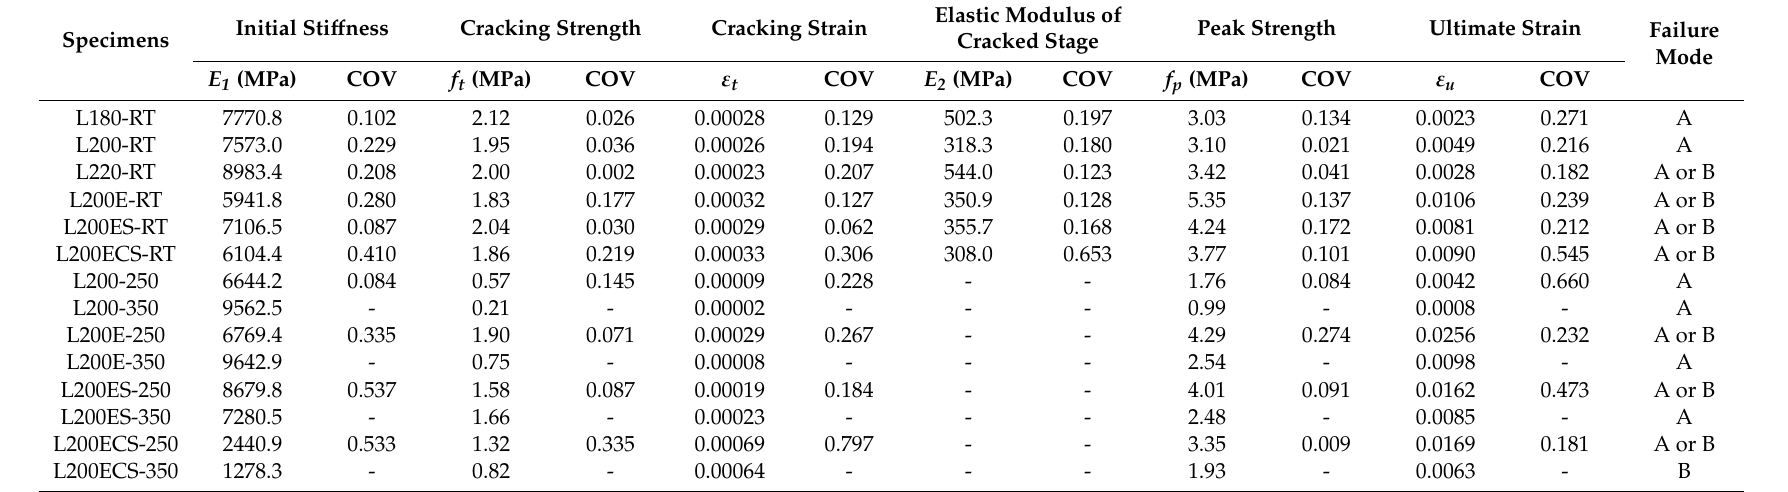
Table 2. Tensile test results of TRM specimens in this